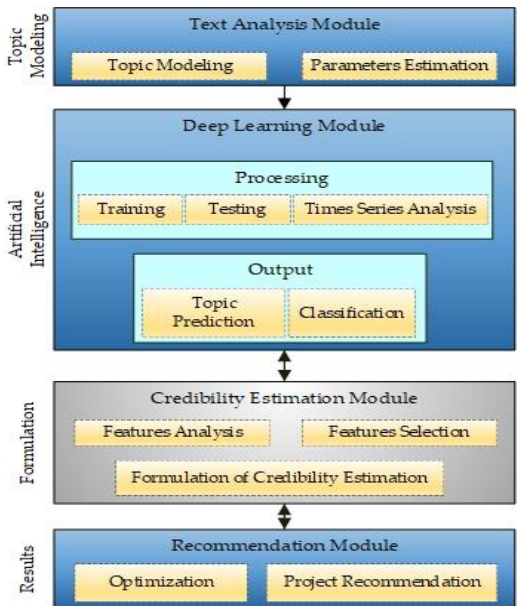
Figure 1. Layered view of the proposed approach.